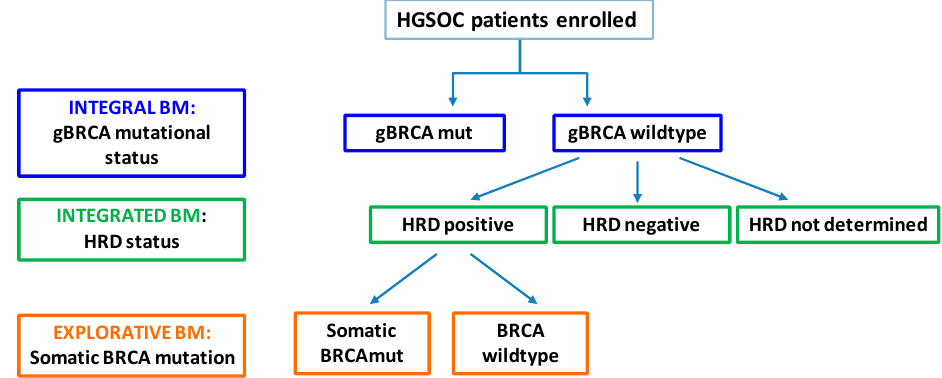
Figure 2. Application of integral, integrated and explorative biomarker analysis in the ENGOT-OV-NOVA16 trial design. (gBRCA: germline BRCA; mut: mutated; HRD: homologous recombination deficiency).